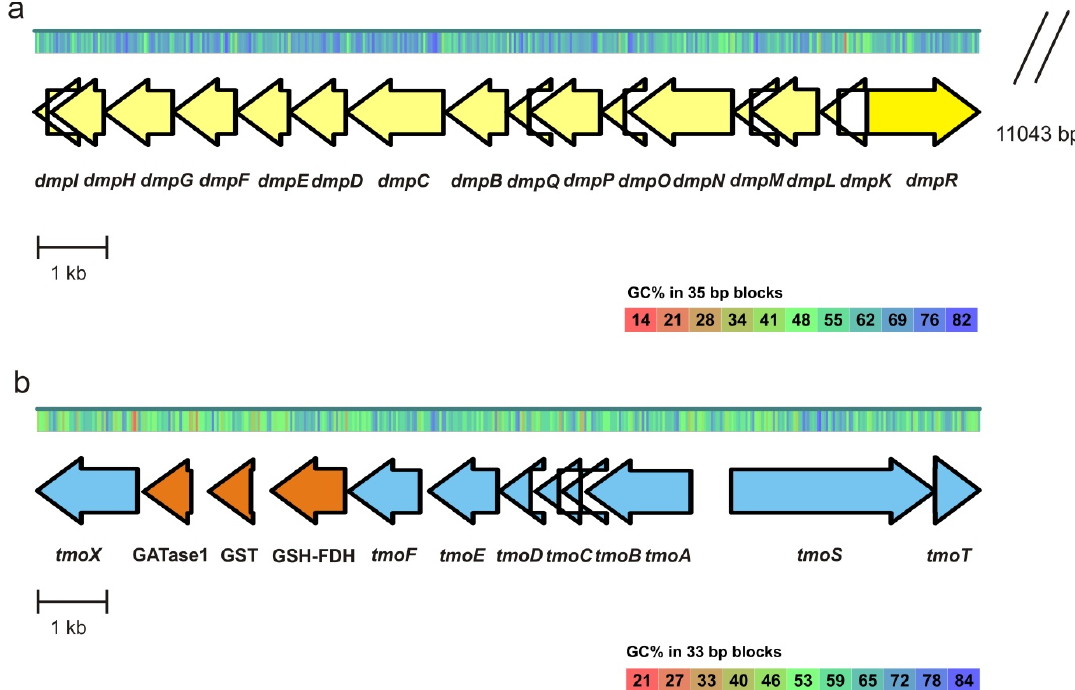
Figure 3. Genetic organization of the phenol degradation operon ( dmp ; GenBank accession number MK134569) and toluene degradation operon ( tmo ; GenBank accession number MK134568) of the Pseudomonas oleovorans ICTN13. ( a ) The genes of the dmp operon (yellow): dmpI , 4-oxalocrotonate isomerase; dmpH , 4-oxalocrotonate decarboxylase; dmpG , 4-hydroxy-2-oxovalerate aldolase; dmpF , acetaldehyde dehydrogenase; dmpE , 2-oxopent-4-dienoate hydratase; dmpD , 2-hydroxymuconic semialdehyde hydrolase; dmpC , 2-hydroxymuconic semialdehyde dehydrogenase; dmpB , catechol 2,3-dioxygenase; dmpQ , ferredoxin-like gene; dmpKLMNOP , components of phenol hydroxylase; dmpR , sigma-54-dependent Fis family transcriptional regulator. ( b ) The genes of the tmo operon (blue): tmoX , outer membrane protein coding gene, transport protein; tmoF , toluene-4-monooxygenase electron transfer component; tmoE , toluene-4-monooxygenase; tmoD , toluene-4-monooxygenase; tmoC , ferredoxin; tmoB , toluene-4-monooxygenase; tmoA , toluene-4-monooxygenase, tmoST , two-component signal transduction system. Genes inserted to the tmo operon (orange): GATase1, type